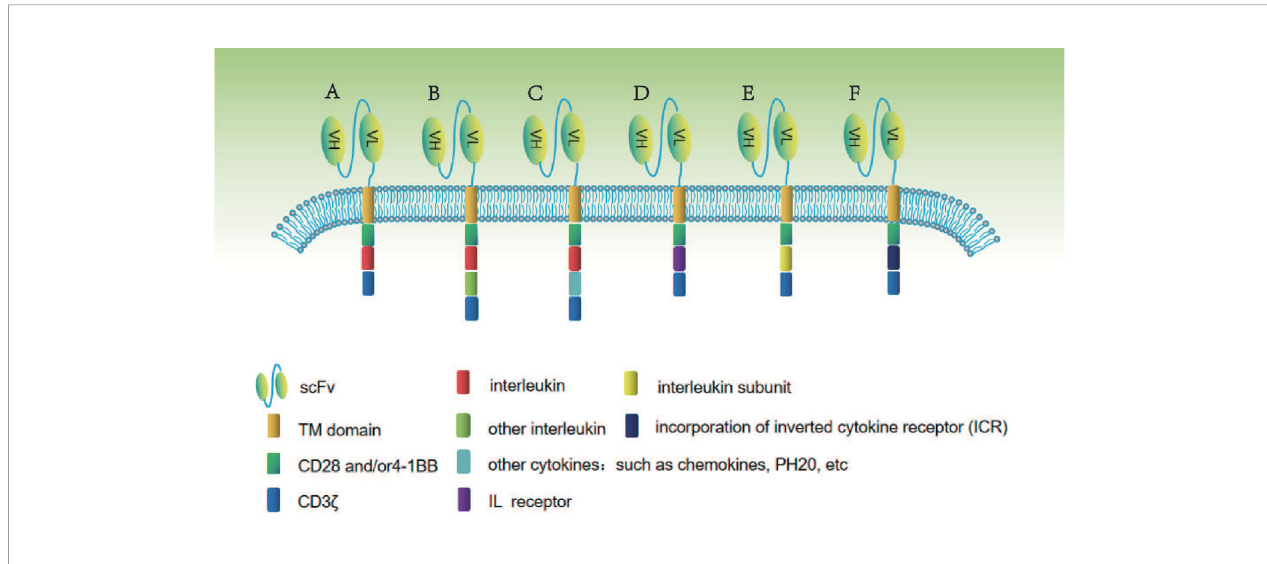
FIGURE 1 | In this fi gure, different methods of constructing gene-edited interleukin-CAR T cells are shown. (A) Co-expression of a single interleukin. (B) Co-expression of two interleukins. (C) Co-expression of interleukin combined with other cytokines. (D) Co-expression of interleukin receptor. (E) Co-expression of interleukin subunit. (F) Co-expression offusion interleukin